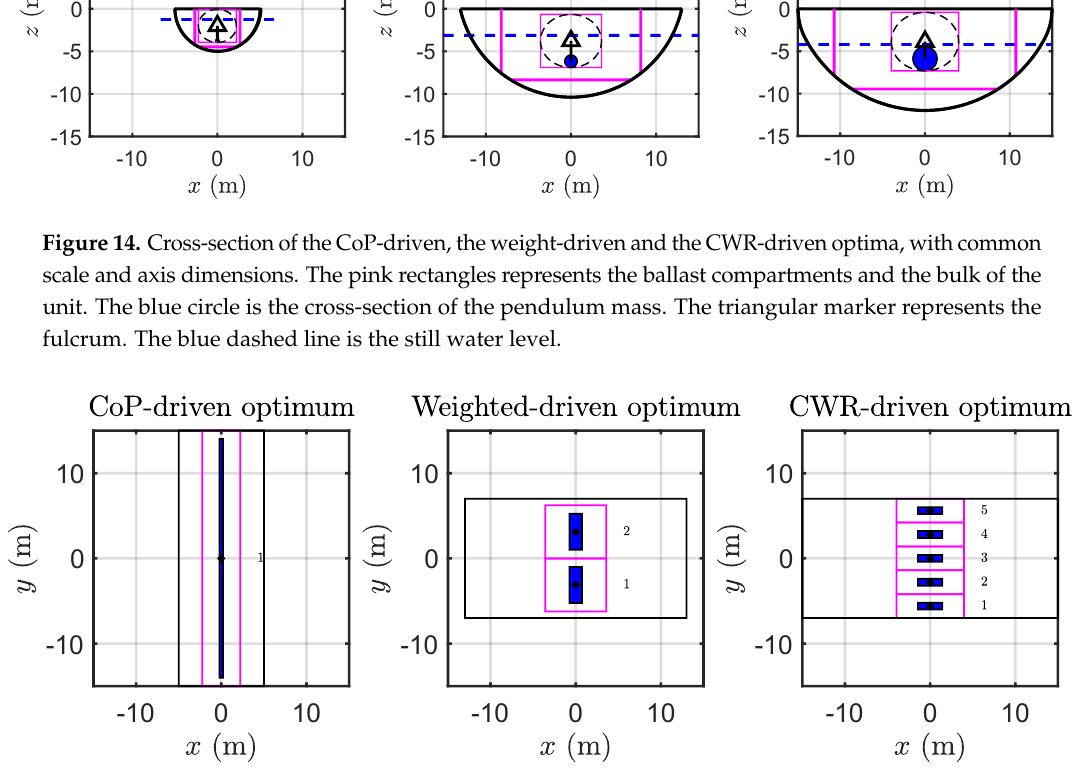
Figure 15. Top view of the CoP-driven, the weight-driven and the CWR-driven optima, with common scale and axis dimensions. The pink rectangles represents the bulk of the unit. The blue rectangle is the pendulum